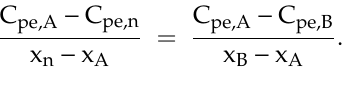
Figure 13. Values of Cpe,i (i = A—red; B—green; C—blue) coefficients for dome structure acc. [39].